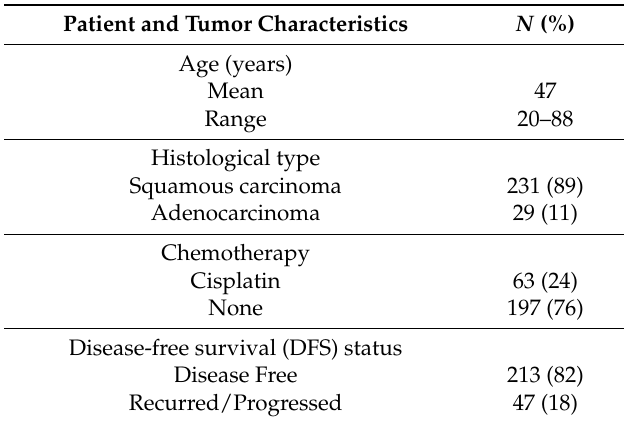
Table 2. Clinical characteristics of cervical cancer patients in TCGA